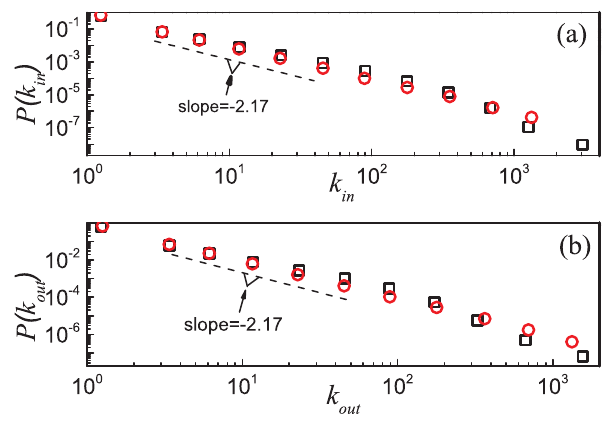
Figure 2. Indegree (a) and outdegree (b) distributions of the Epinions social network (black squares) and simulation results (red circles) based on the model. The dashed lines in both panels have a slope { 2 : 17 as the analytic results in Eqs. (17) and (31) suggested. The simulated network is generated by the model with the parameters N ~ 75879 , m & 4 : 34 and p & 0 : 08 , as determined by the mean degree S k T and reciprocity r of the Epinions social network. Data points are averages over the logarithmic bins of the indegree k in and